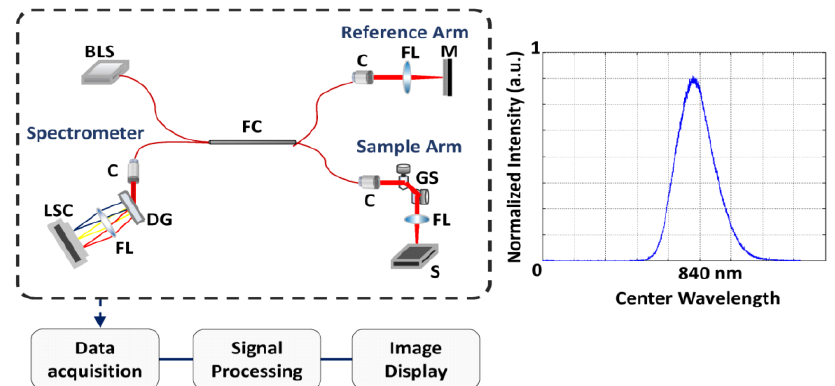
Figure 1. Proposed spectral domain optical coherence tomography (SD-OCT) system along with the broadband laser spectrum. (BLS: broadband laser source; C: collimator; DG: diffraction grating; FC: fiber coupler; FL: focusing lens; GS: galvanometer scanners; LSC: line scan camera; M: mirror; S: sample).